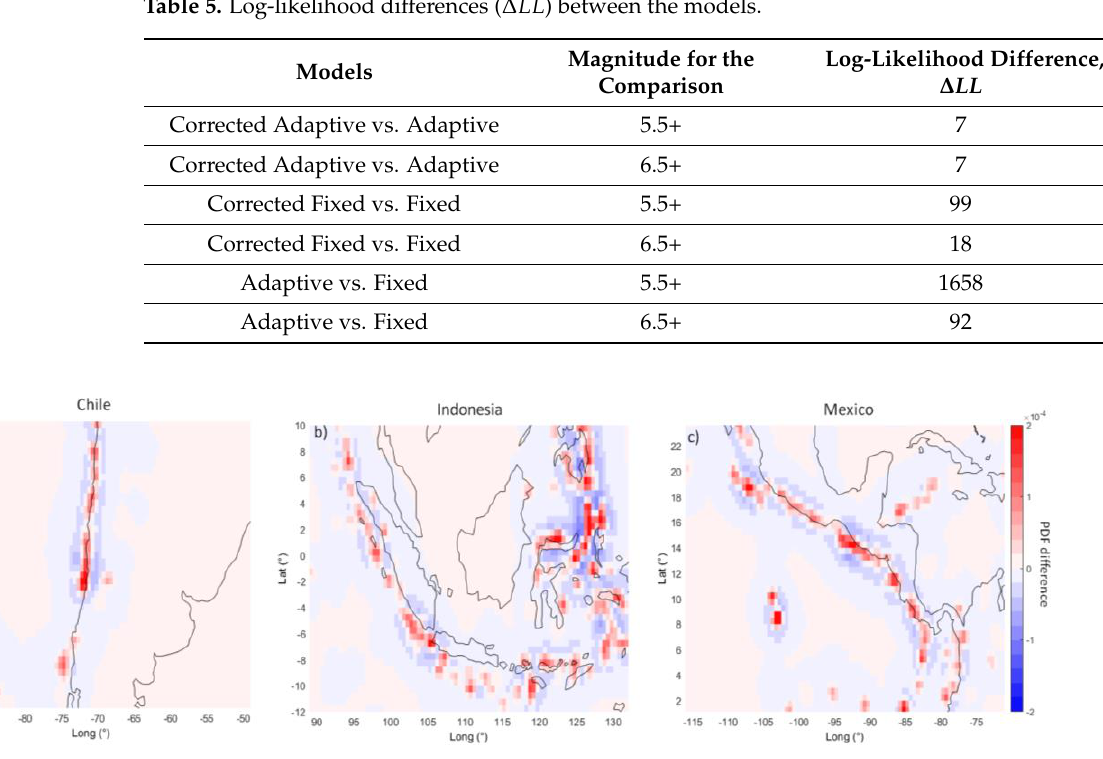
Figure 5. The difference between the normalized seismicity rates (linear scale) of the adaptive and fixed corrected models (Adaptive corrected − Fixed corrected ) in some zones in the world: Chile ( a ), Indonesia ( b ), and Mexico ( c ). Table 5. Log-likelihood differences ( ∆𝐿𝐿 ) between the models